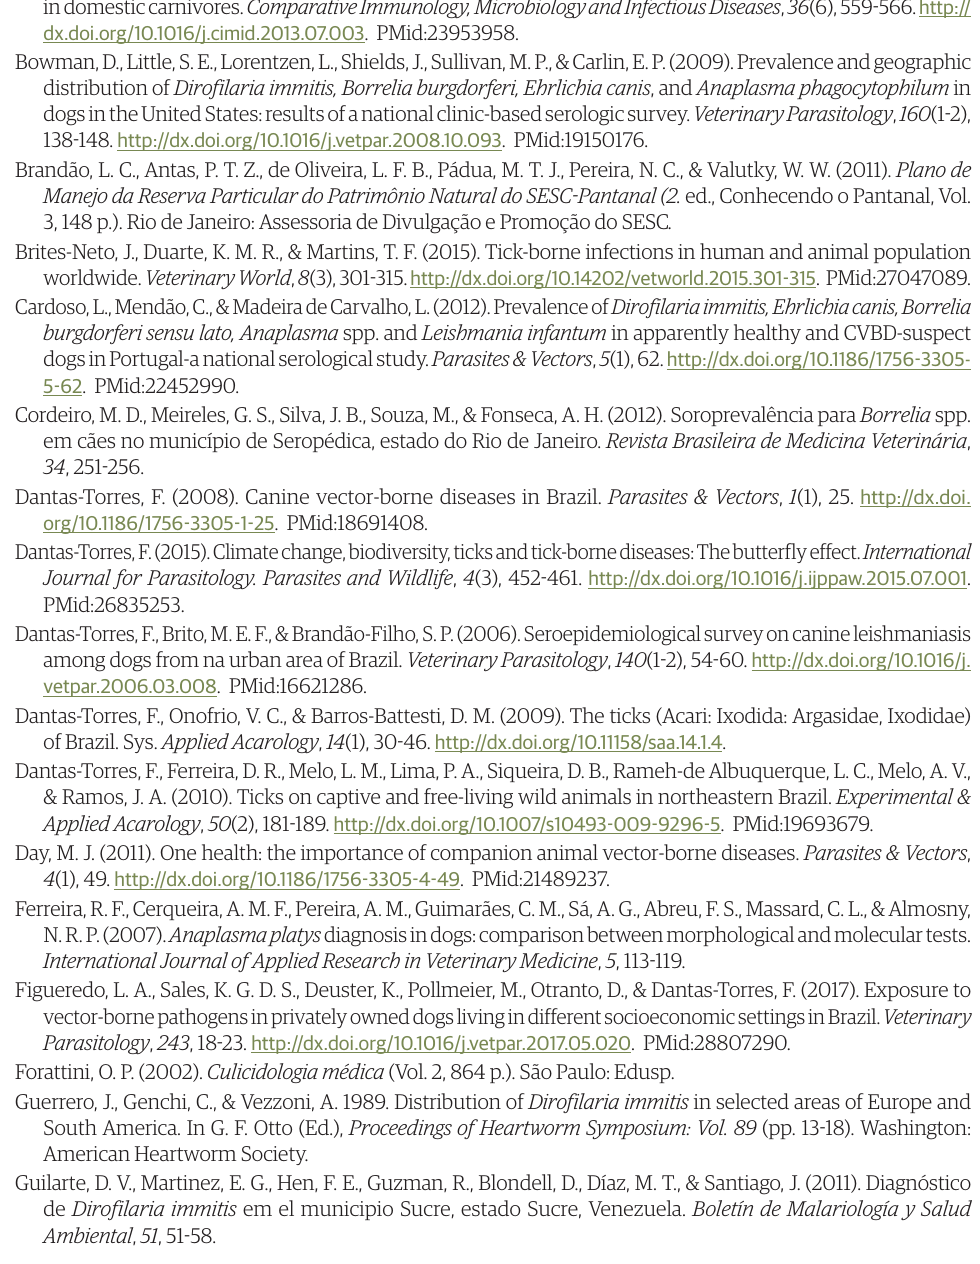
Alberigi et al. 2019. Brazilian Journal of Veterinary Medicine, 41, e103719. DOI: